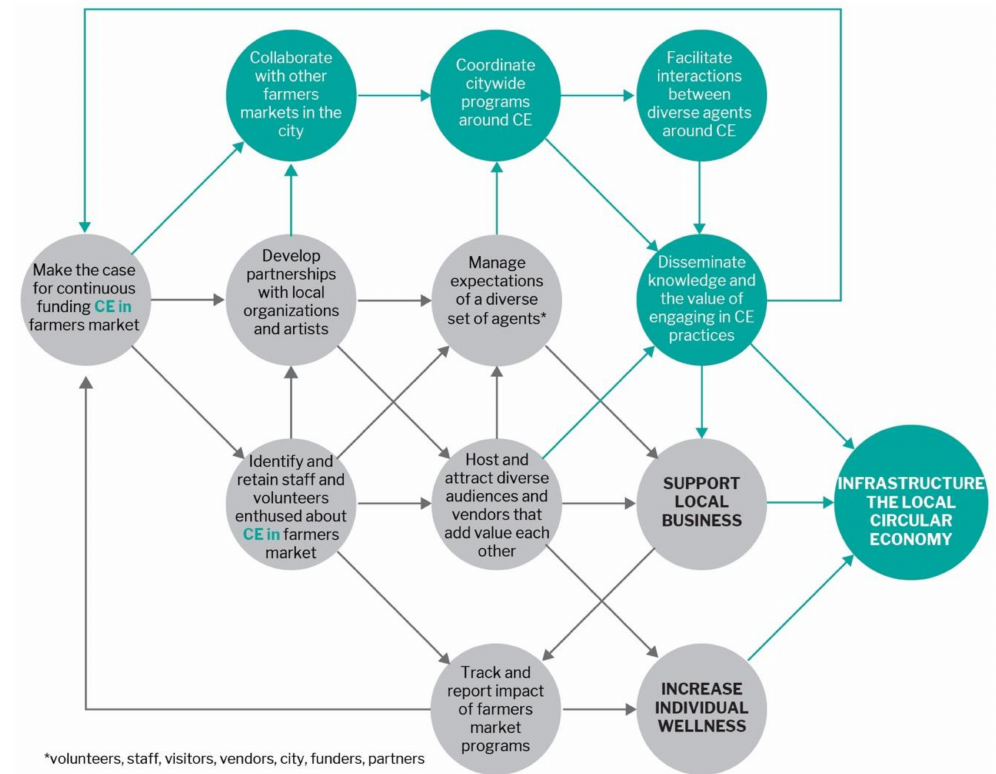
Note: Grey elements illustrate existing competencies needed to bring a farmers market to life, and their interdependencies (arrows). Green elements (arrows, texts, and circles) situate the changes and the four new competencies identified by researchers and participants. Figure 4. Competencies needed for infrastructuring the local CE through farmers